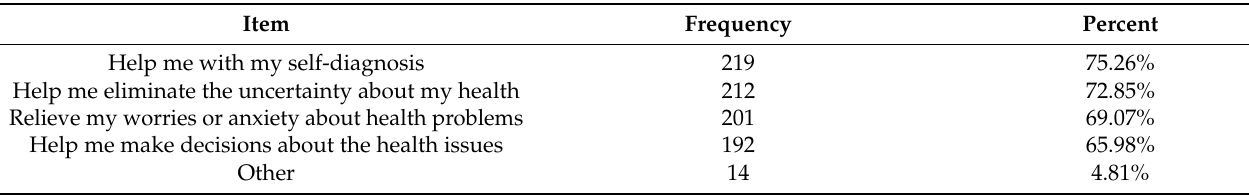
Table 6. Motivations for health information search.